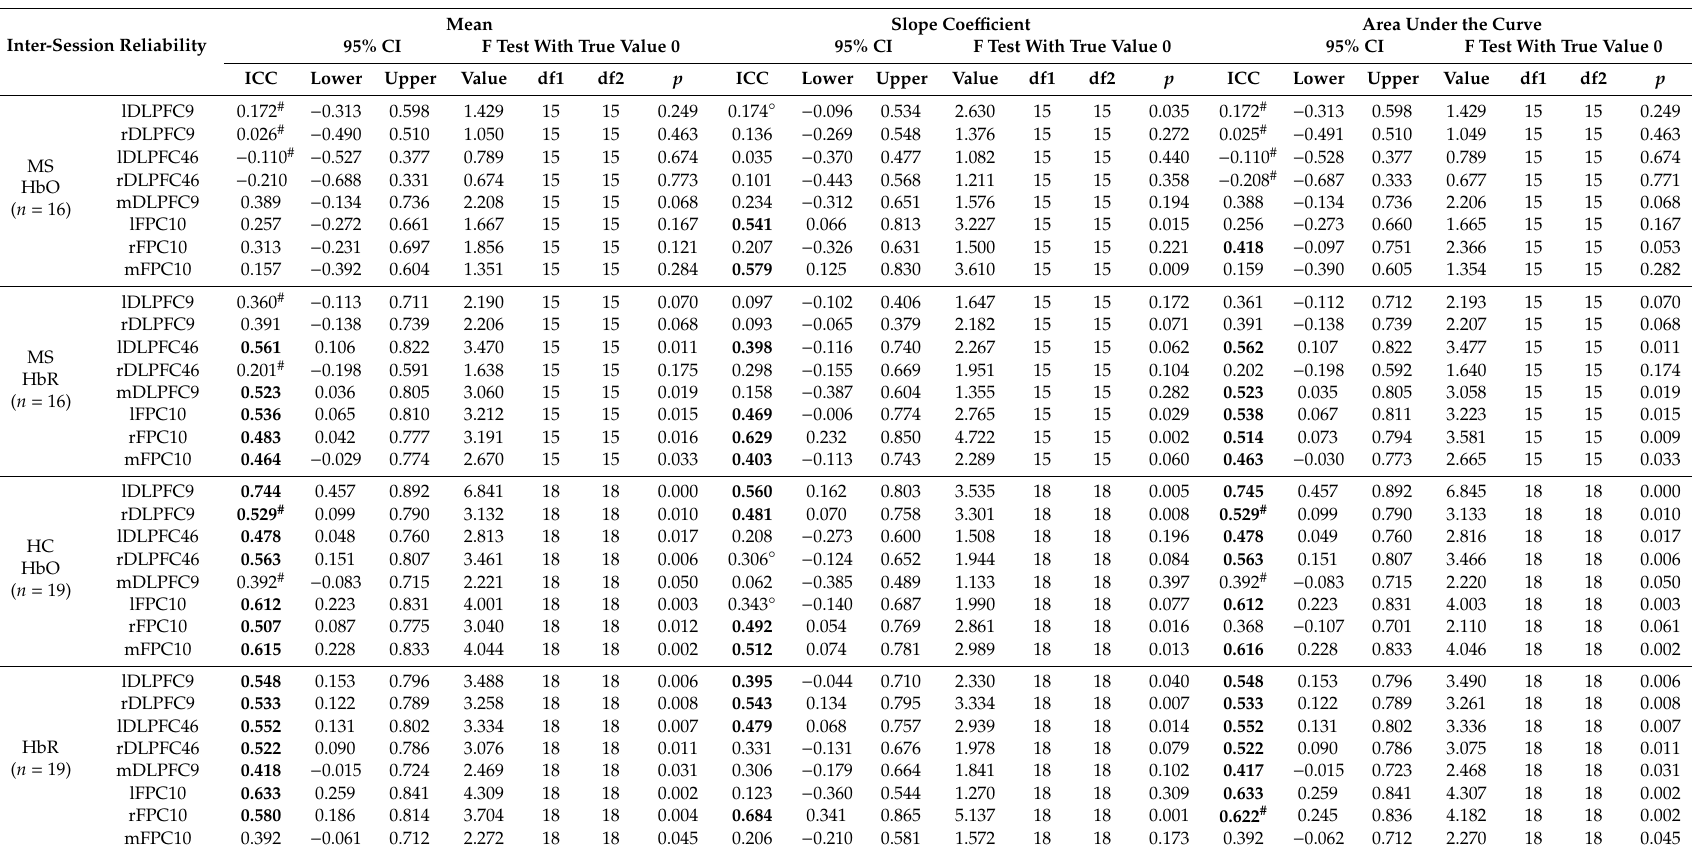
Table 3. Intraclass correlation coe ffi cient of test and retest data of both groups (MS /